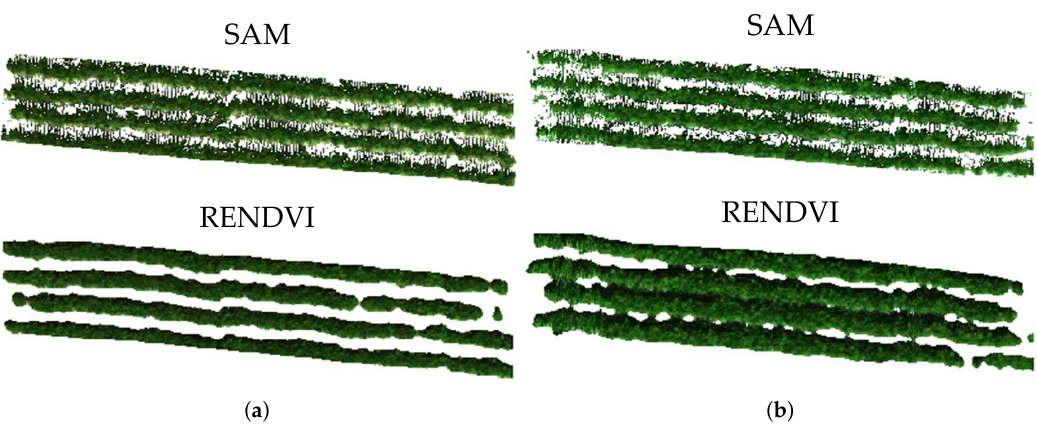
Figure 21. A comparison of the vegetation detection results for cases where ( a ) vegetation canopy and the background are distinguishable and ( b ) canopy closure has commenced, i.e., a dense canopy is